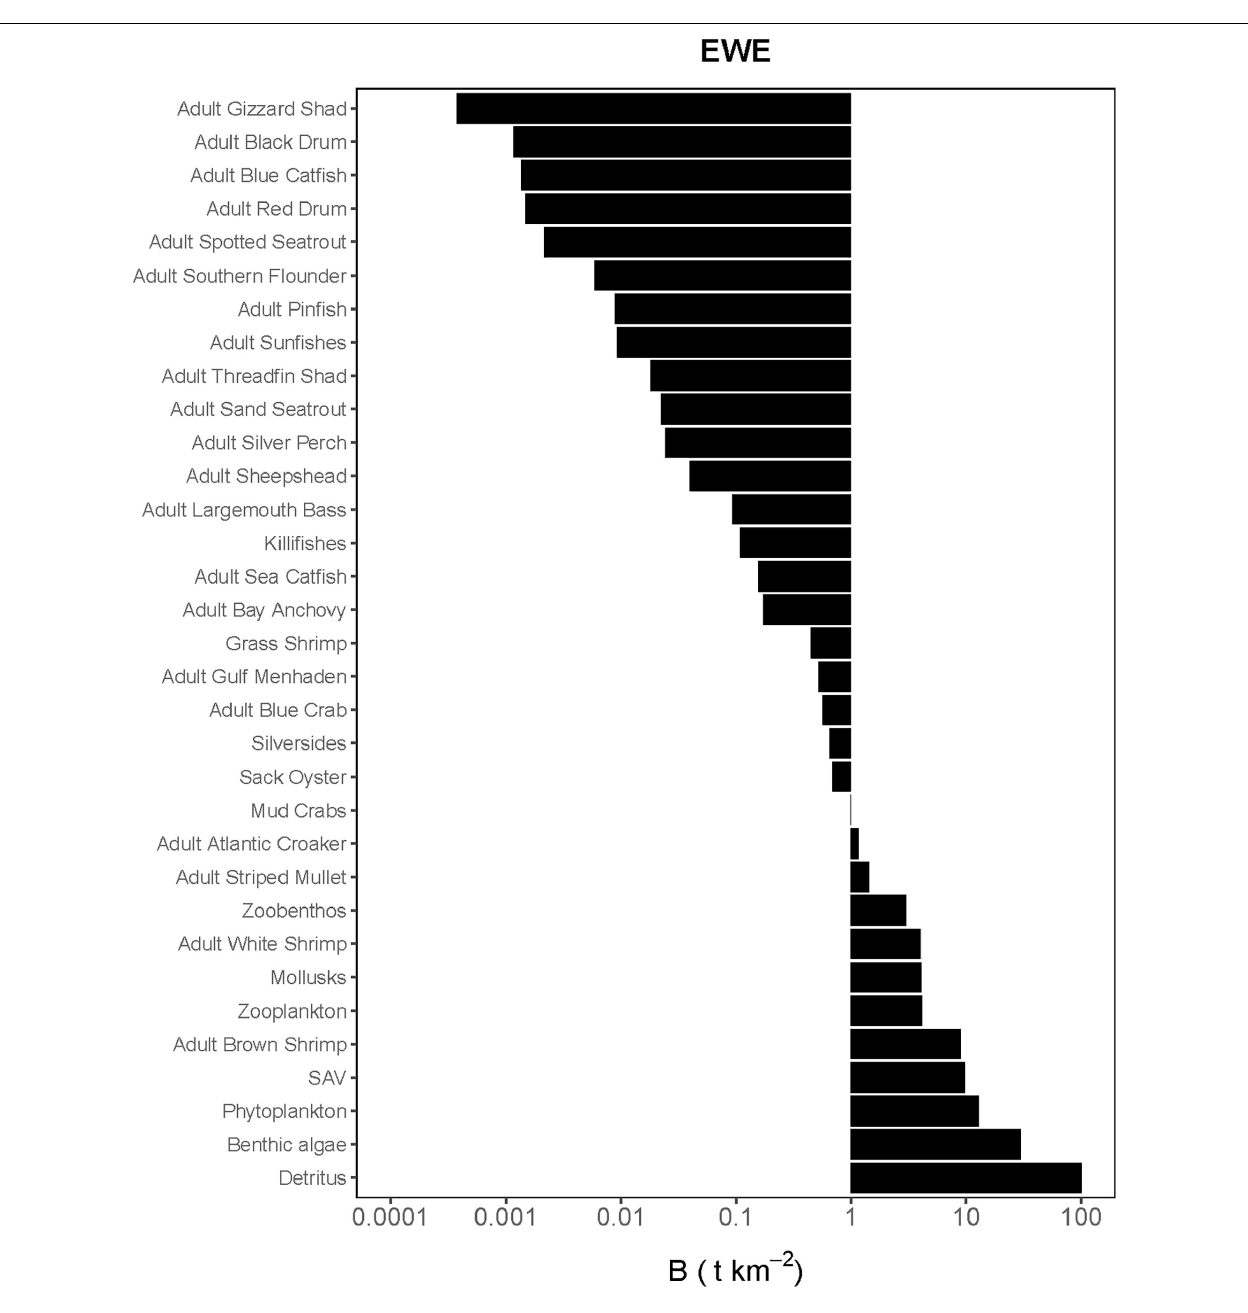
CASM daily predicted biomasses of the key species groups (averaged over polygons) also showed an adequate fit to the observed biomasses well ( Figure 4B ); the fit statistics showed variable but generally high correlation (overall average r = 0.4, with 50% of species having a r > 0.6) and low percent bias (average = ± 30% for moderate to high biomass species) across species groups (see Table 5 in Dynamic Solutions,